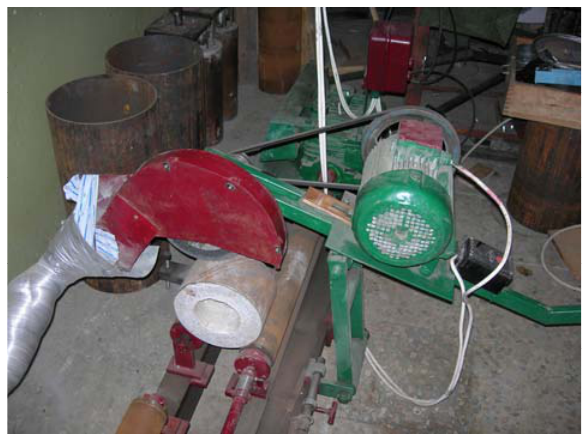
Fig 2 . Cutting machine used for preparing the